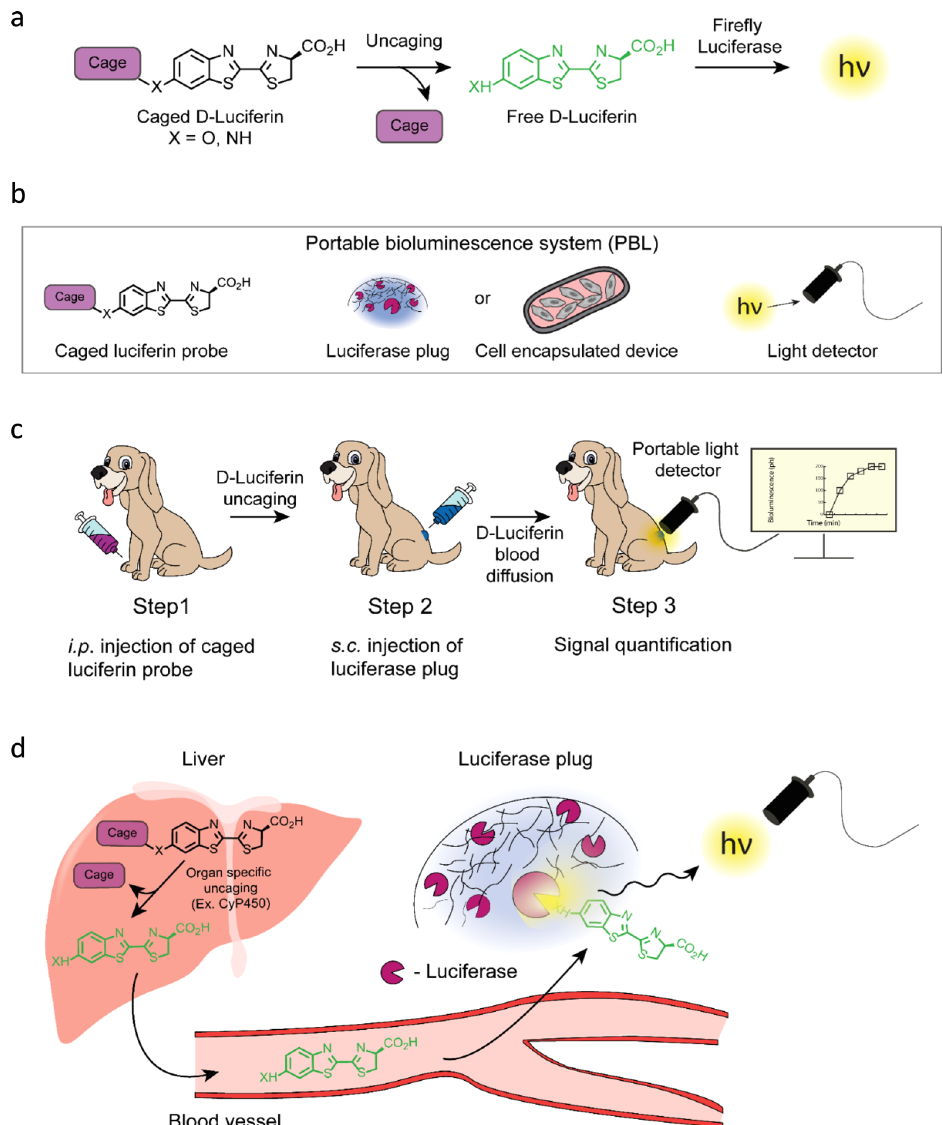
Fig. 1 General concept of the PBL method for noninvasive in vivo monitoring of biological processes. a Basic principle of functional BLI. A bioluminescent probe with caged luciferin interacts with the targeted biological process. This reaction leads to uncaging of luciferin, which in turn is able to react with luciferase to produce bioluminescent light. Importantly, the amount of light generated as the result of this uncaging is proportional to the level of functional activity of the biological process of interest. b Three main components of the PBL system include ( a ) a caged luciferin probe that releases free luciferin by a speci fi c biological process; b luciferase biodegradable plug or a cell encapsulating device with luciferase expressing cells that produces light proportionally to the amount of released luciferin; c sensitive portable light detector for signal quanti fi cation. c A typical PBL experiment employs an administration of a functional bioluminescent probe based on the caged luciferin scaffold followed by s.c. injection of a biodegradable luciferase plug. The light production is quanti fi ed by the portable light detector that is placed directly on top of the area of the plug. d Upon injection, a caged luciferin probe reaches the target organ (e.g., liver) where it gets uncaged by a speci fi c biological process or enzyme (e.g., CyP450). Subsequently, free luciferin diffuses into the bloodstream and eventually reaches the luciferase containing plug. The luciferase enzyme in the plug produces light proportionally to the level of luciferin. The light is quanti fi ed by a sensitive light detector placed on top of the luciferase